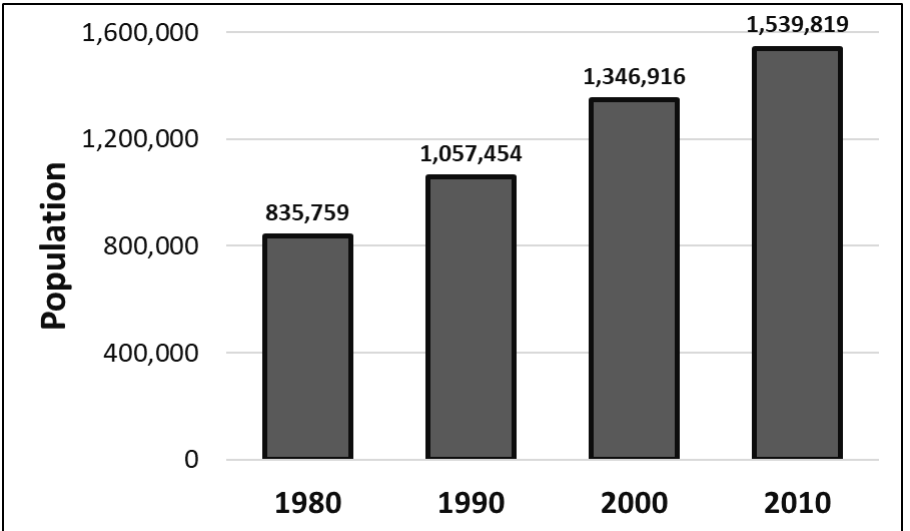
Figure 2. Population of Puebla between 1980 and 2010.